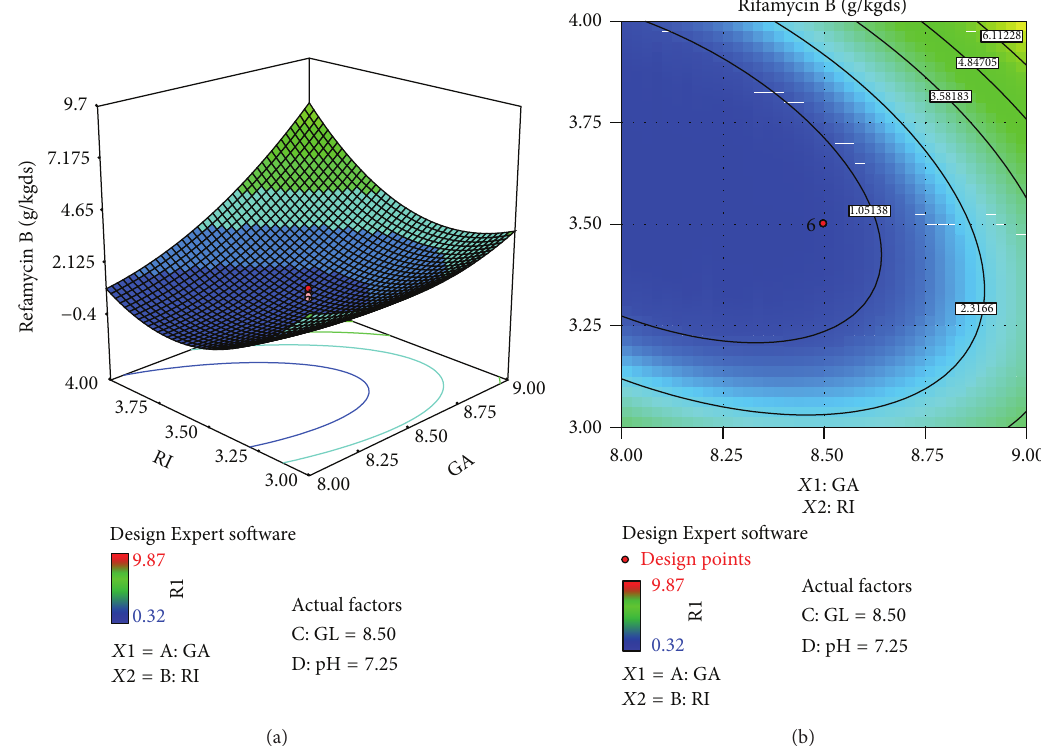
Figure 7: Surface and contour plot for rifamycin B production at varying concentrations of 𝑋4 , galactose (GA), and 𝑋3 , ribose (RI).